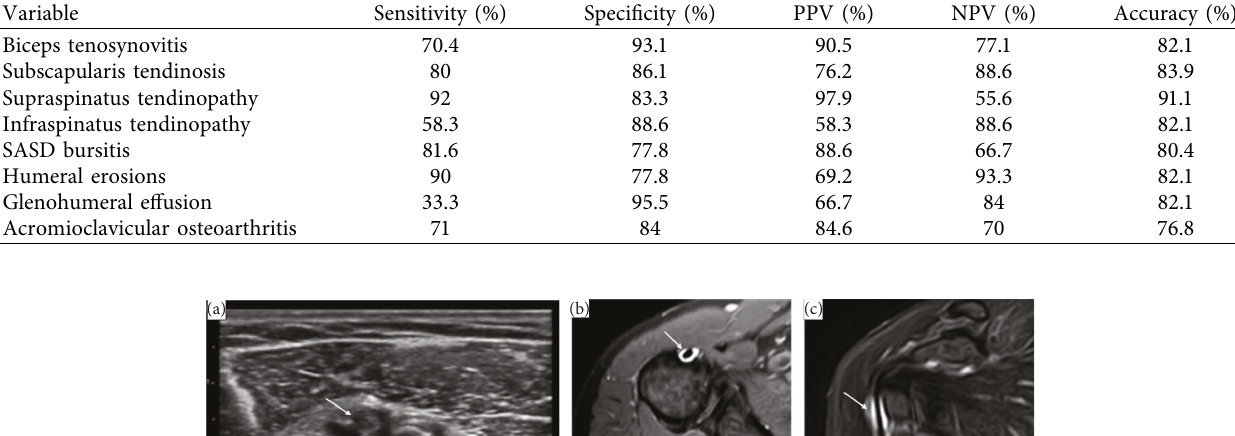
Table 5: Comparison of ultrasound versus magnetic resonance in detecting shoulder pathologies in the study HD patients ( n � 56